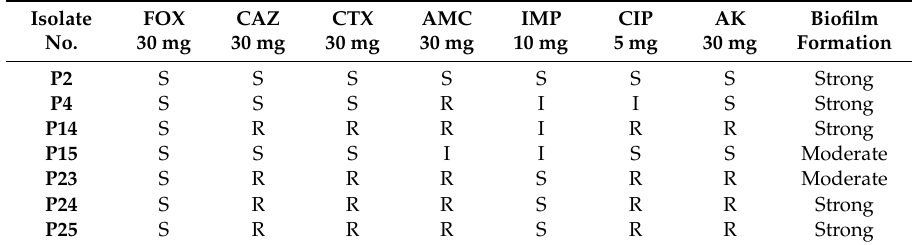
Table 1. Antimicrobial susceptibility patterns of P. mirabilis isolates. Isolate No.